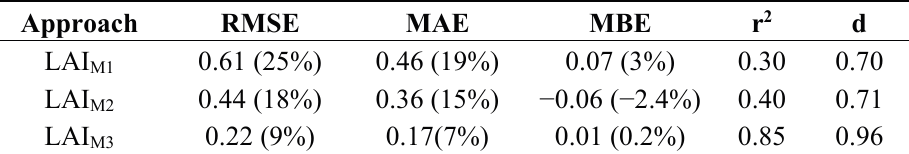
Table 3. Statistical analysis of leaf area index estimated by the LAI M method using a constant k value (LAI M1 ), a k derived from f f (LAI M2 ) and using the instantaneous fraction of incident radiation absorbed by the canopy as a proxy value for k (LAI M3 ).